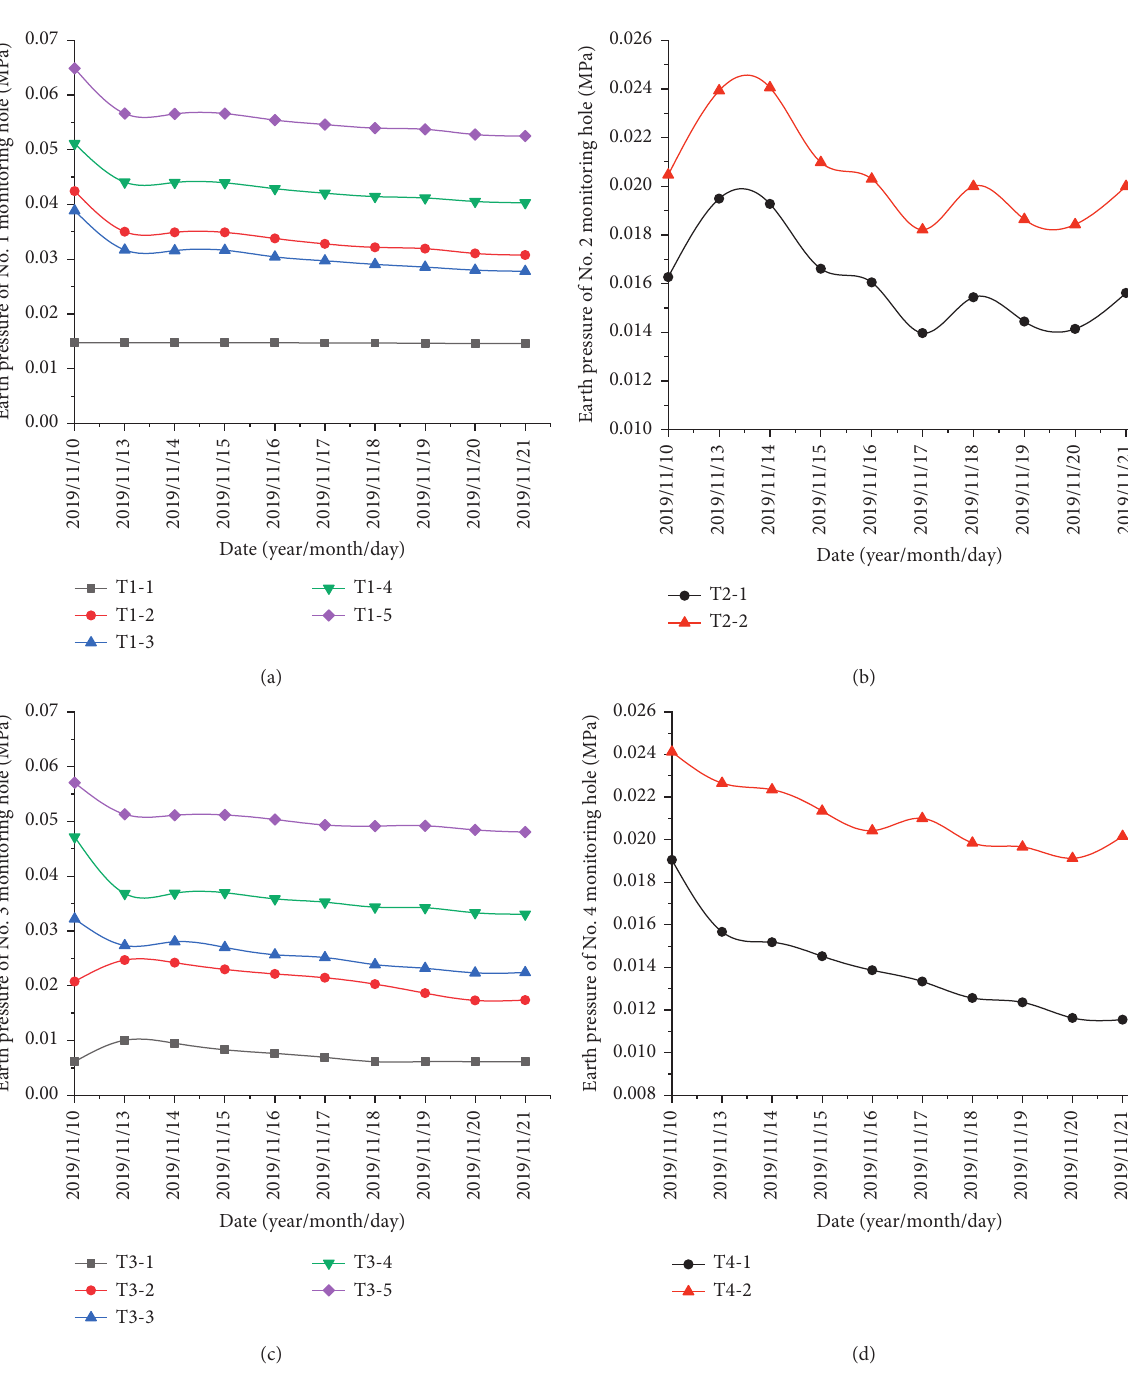
Figure 9: Variation diagram of earth pressure during Hole 1 jacking. (a) Earth pressure of No.1 monitoring hole. (b) Earth pressure of No. 2 monitoring hole. (c) Earth pressure of No. 3 monitoring hole. (d) Earth pressure of No. 4 monitoring